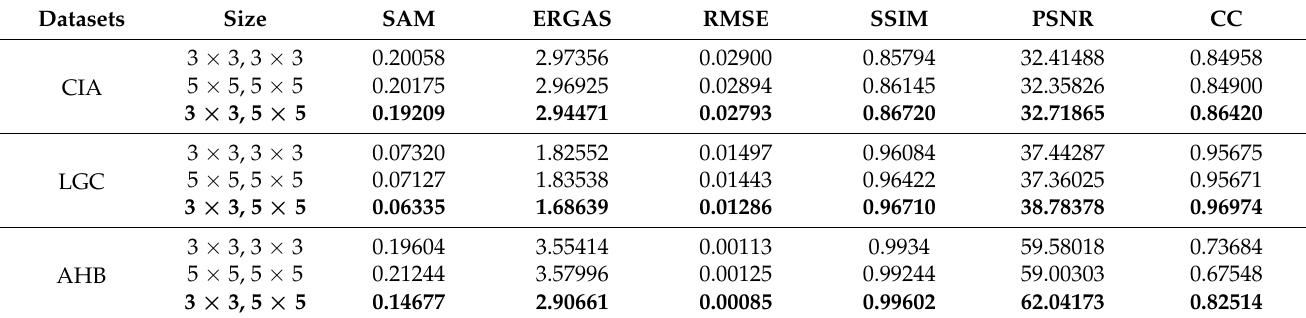
Table 6. Average evaluation values of Extract Nets with different sizes of receptive fields on the three datasets. Datasets